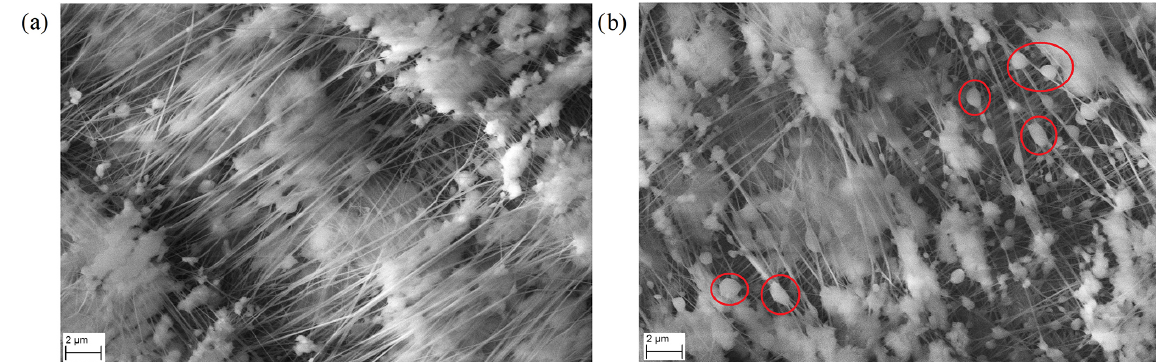
Figure 6. SEM pictures. (a) Magnification of a clean FIGAERO filter with no collected particles. (b) A magnification of a FIGAERO filter with collected 300nm sized PEG-8 particles. Red circles in panel (b) emphasize selected spots where liquid PEG-8 particles are